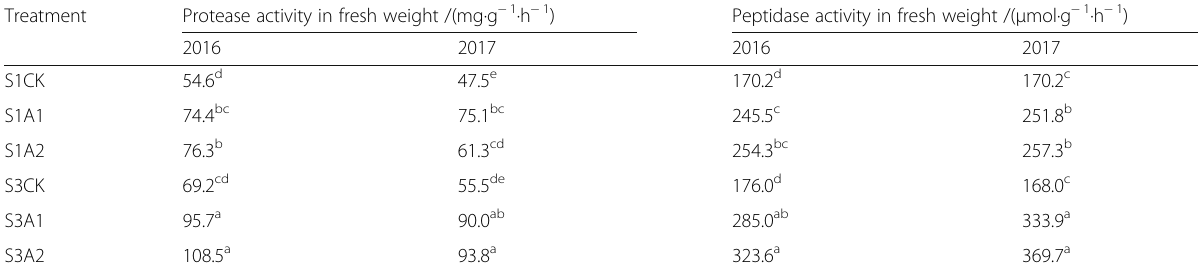
Table 2 The effect of application of 5 amino acids composition and 21 amino acids composition on flower protease and peptidase activities of the two Bt cotton cultivars at flowering period